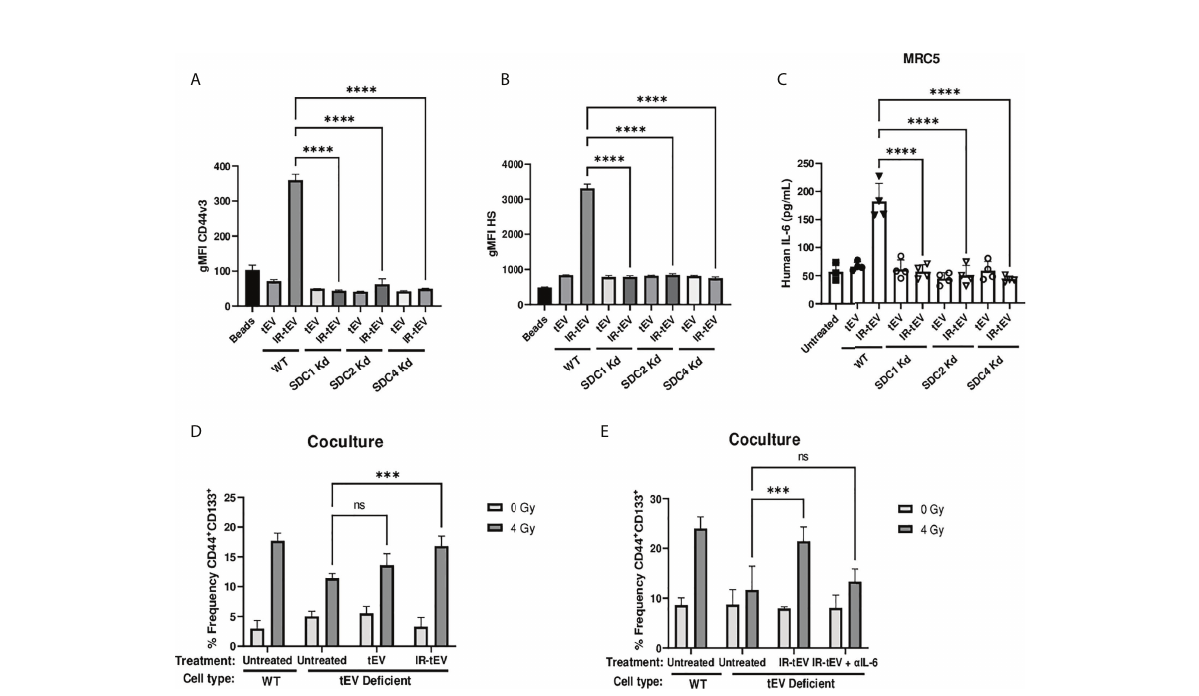
FIGURE 4 IR-tEV secretion is dependent upon the ESCRT pathway. (A, B) tEVs were collected from WT or SDC1, SDC2, or SDC4 KO MB-MDA-231 cells and CD44v3 (A) and HS (B) levels were assessed via bead assisted fl ow cytometry. X axis indicates from which parent cells the tEVs were derived. Control represents unbound beads incubated with antibody cocktail. (C) MRC5 cells were incubated with tEVs collected from WT or SDC1, SDC2, or SDC4 Kd MB-MDA-231 cells. IL-6 levels were measured via ELISA. (D) WT or SDC1 kd (tEV De fi cient) MDA-MB-231 cells were cultured with fi broblasts with or without supplementation with WT tEVs. Protein surface markers were assessed via fl ow cytometry. (E) WT or SDC1 kd (tEV De fi cient) MDA-MB-231 cells were cocultured with fi broblasts with supplementation of WT IR-tEVs in the presence of an IL-6 neutralizing antibody. Protein surface markers were assessed via fl ow cytometry. Statistical signi fi cance assessed with ANOVA P < 0.05. (C-E) Data points represent biological replicates. ** denotes a P value < 0.005. *** denotes a P value < 0.0005. **** denotes a P value < 0.00005. These values were the results of ANOVA analyses performed on GraphPad. “ ns ” represents a value for P that is greater than 0.05 and stands for “ Not Signi fi cant ”